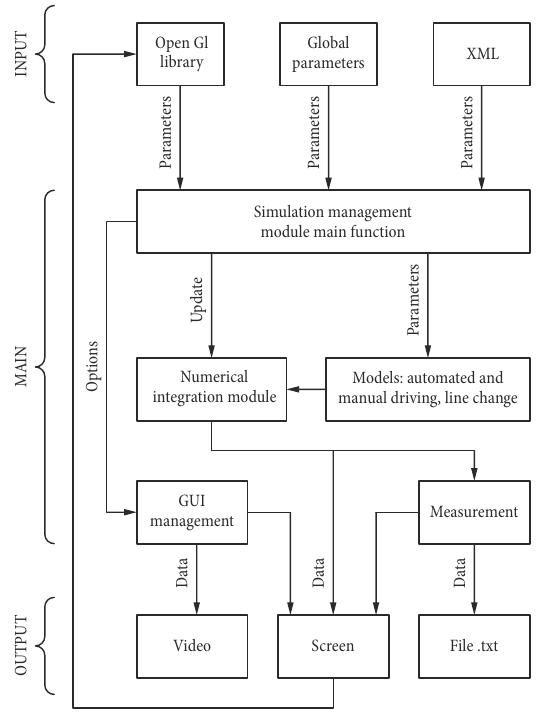
Global parameters XML